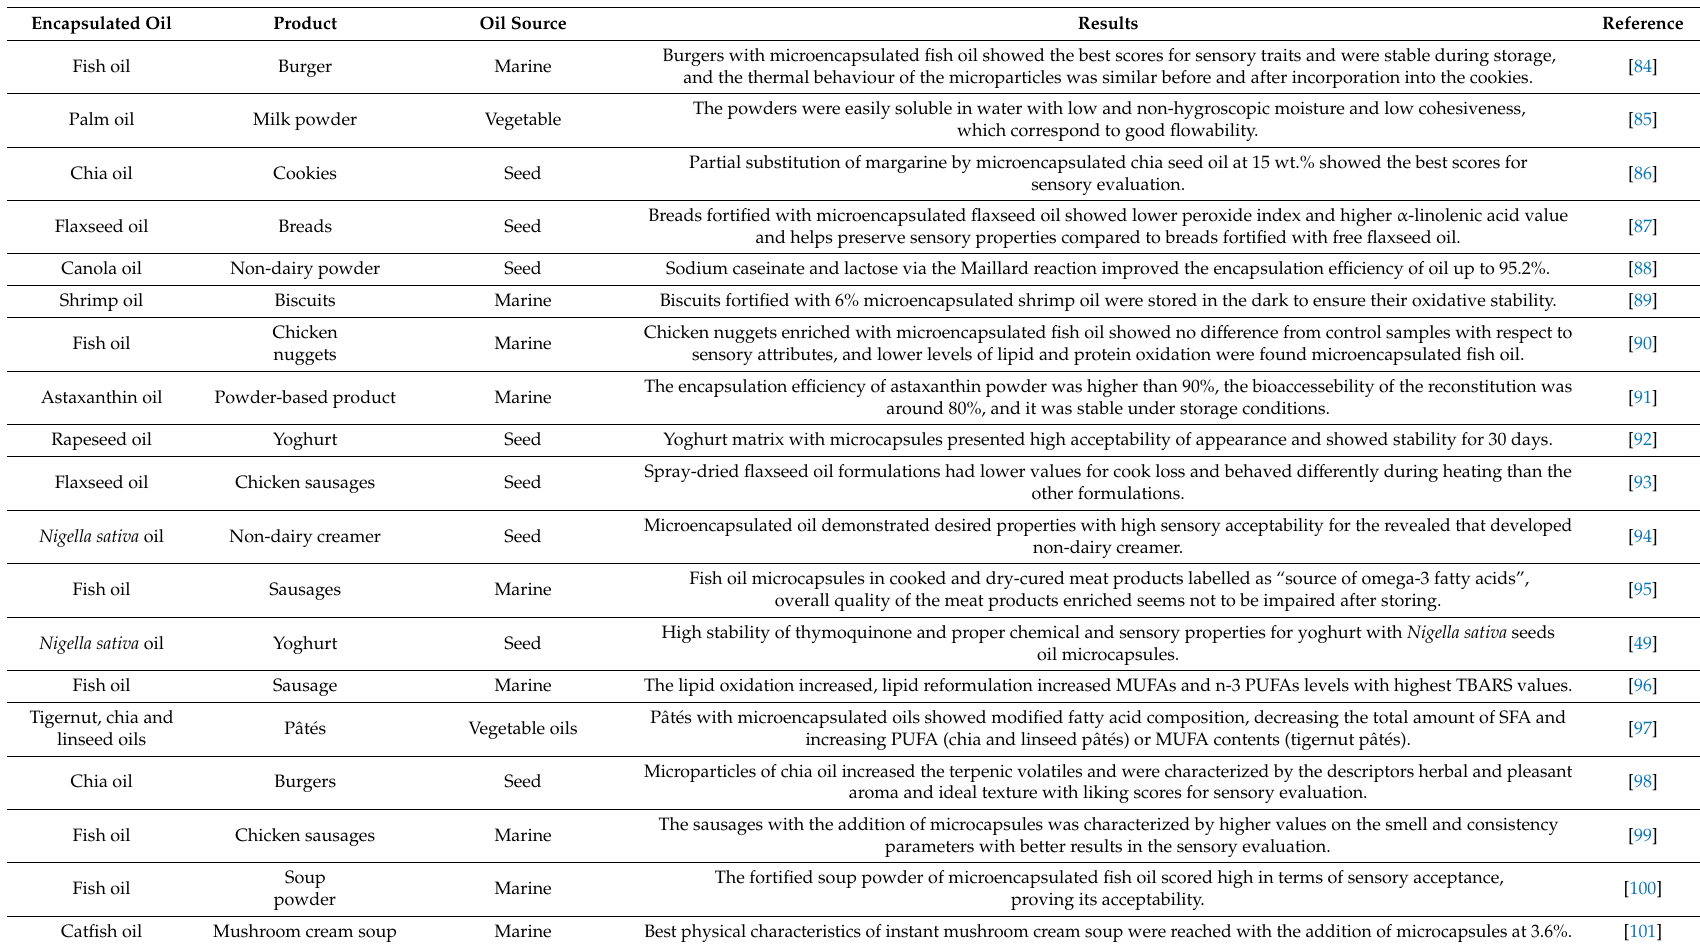
Table 3. Applications of encapsulated oils using the spray drying technique in several functional food